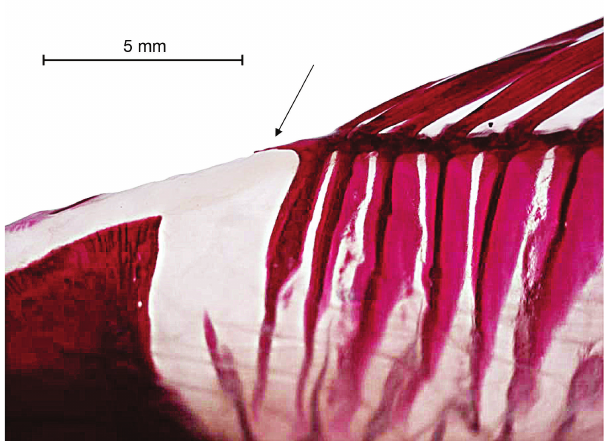
Fig. 1 . Anterior portion of dorsal-fin skeleton of Gymno- geophagus peliochelynion (anterior towards left), UFRGS 8076, paratype, 74.2 mm SL. Arrow indicates the anterior spine in the first dorsal pterygiophore. Note the lack of su- praneurals between supraoccipital and first dorsal pterygio-